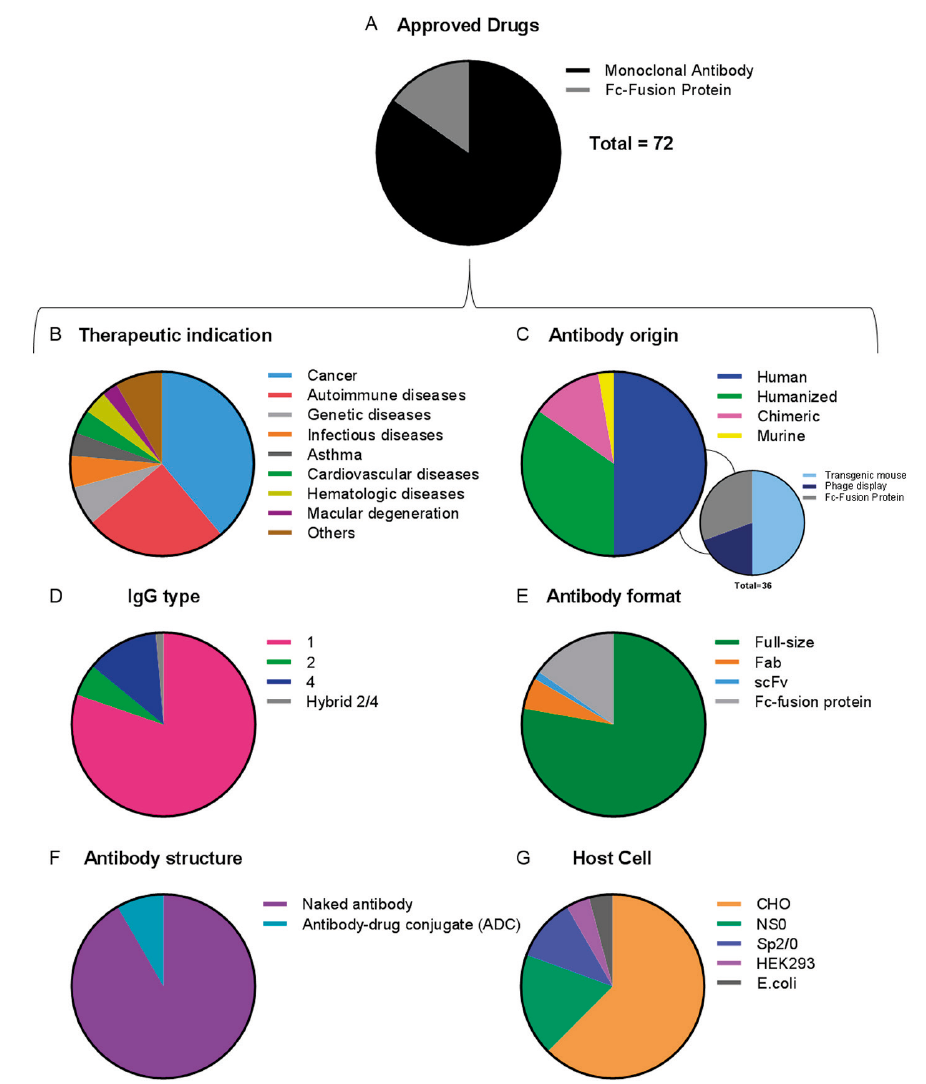
FIGURE 3 – Monoclonal antibodies (including Fc-fusion proteins) currently approved by FDA and/or EMA as of October 2017, classified by (A) type of molecule, (B) therapeutic indication, (C) antibody origin and the technology used for the development of human mAbs; (D) IgG type, (E) antibody format, (F) antibody structure and (G) host